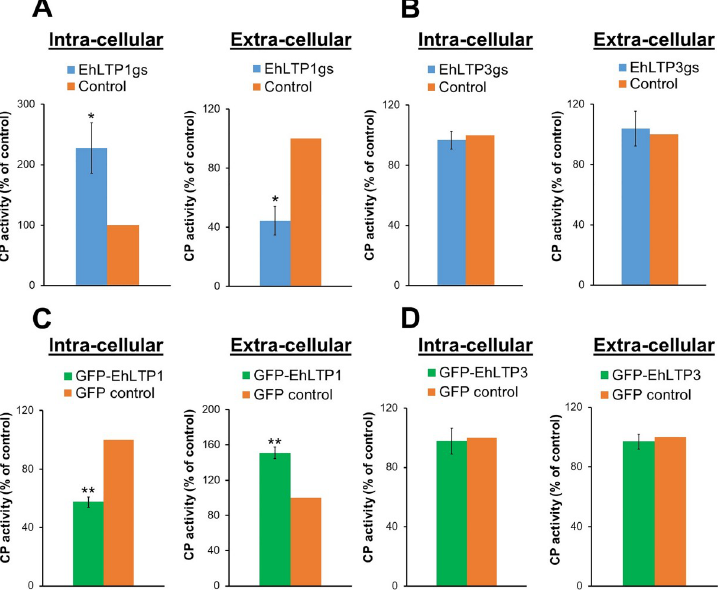
Fig 5. Effects of gene silencing of EhLTP1 (A) and EhLTP3 (B) or overexpression of EhLTP1 (C) and EhLTP3 (D) on cysteine protease (CP) secretion by E . histolytica trophozoites. The CP activity in the total lysate (intra-cellular CP activity) and culture supernatant (extra-cellular CP activity) of the transformants was measured as described in Methods section. The activities are shown as the percentage relative to the vector control transformant [psAP2 control (A, B) or GFP control (C, D)]. The experiment was repeated three times independently in duplicates (N = 3 with error bars indicating standard deviation). Statistical comparisons were made by Student’s t-test ( � P � 0.05, �� P � 0.005, ��� P �